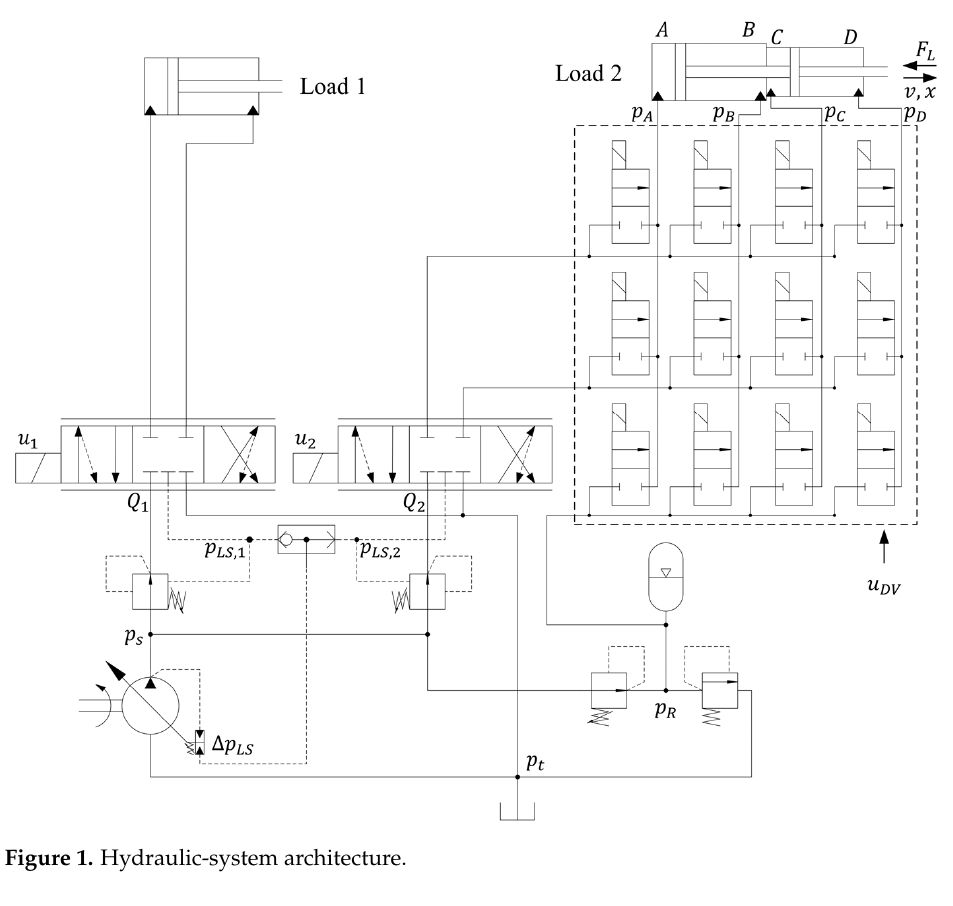
Figure 1. Hydraulic-system architecture.